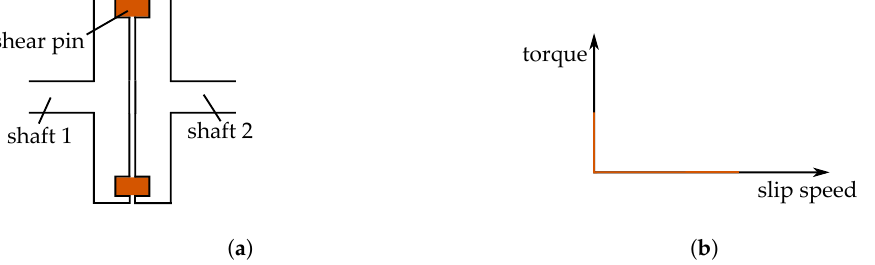
Figure 10. Shear pin type of torque limiter: ( a ) Illustration ( b ) Ideal torque vs. slip speed